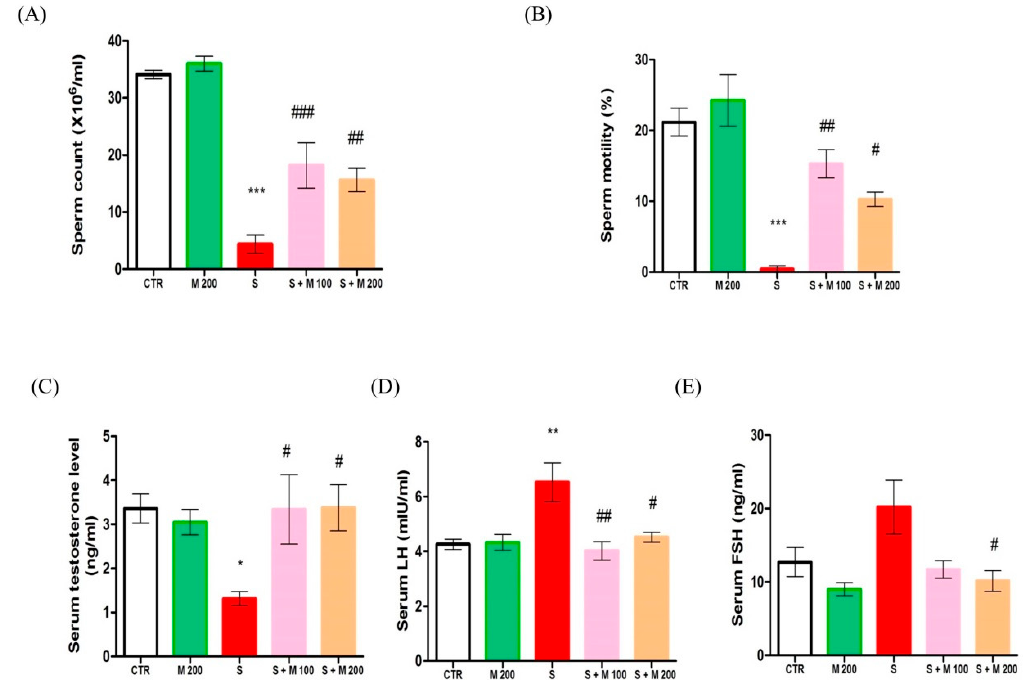
Figure 1. The e ff ect of MOTILIPERM on epididymal sperm count, sperm motility, and serum hormone levels in immobilization stress-treated male SD rats. ( A ) Sperm count in the epididymis. ( B ) Sperm motility in the epididymis. ( C ) Serum testosterone levels. ( D ) Serum luteinizing hormone (LH) levels. ( E ) Serum follicle stimulating hormone (FSH) levels. Data are presented as mean ± SEM. The di ff erences were tested by one-way ANOVA followed by Tukey’s post-hoc test; n = 10 for each group. * p < 0.05, ** p < 0.01, and *** p < 0.001 denote significant di ff erence compared to the CTR group; # p < 0.05, ## p < 0.01, and ### p < 0.001 denote significant di ff erence compared to the S group. CTR: control; M 200: MOTILIPERM 200 mg/kg p.o.; S: stress by immobilization group; S + M 100: stress by immobilization + MOTILIPERM 100 mg/kg p.o.; S + M 200: stress by immobilization + MOTILIPERM 200 mg/kg p.o.; p.o.: per oral; ANOVA: analysis of variance; SEM: standard error of the mean.